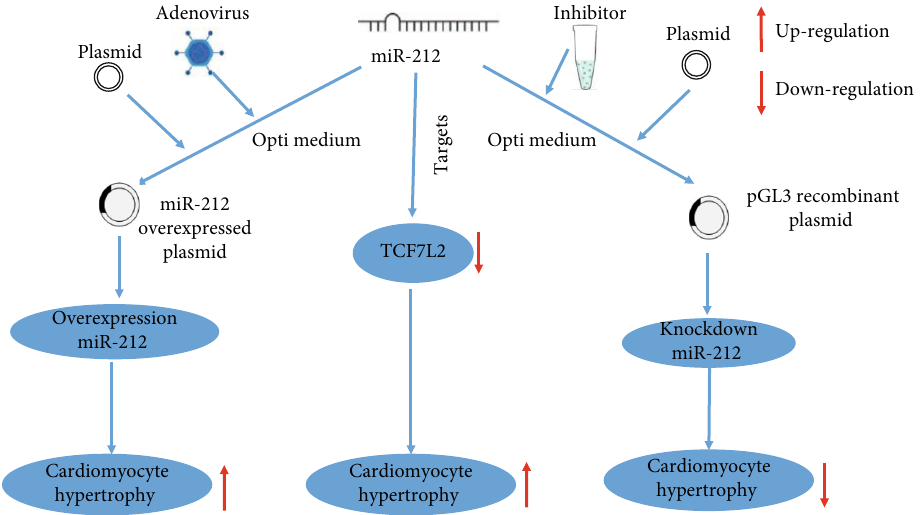
Figure 5: Schematic diagram of the molecular mechanism of miR-212 regulating CH by targeting